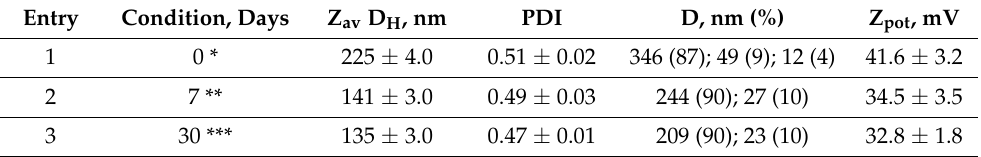
Table 1. Values for the polydispersity indexes (PDI), Z -average (Z av ) diameters, diameters of the populations (D) as percentages (%) and zeta-potentials (Z pot ) of nanoparticles formed by 1,1 (cid:48) -{[3,5-bis((dodecyloxycarbonyl)-4-phenyl-1,4-dihydropyridine-2,6-diyl]bis-(methylene)}bis [4-(anthracen-9-yl)pyridin-1-ium] dibromide ( 4 ) at a concentration of 0.1 mM in an aqueous solution obtained by DLS measurements. The PDI value describes the polydispersity of a sample; the D of a population shows the size of each fraction of nanoparticles (%), the Z av diameter represents the average hydrodynamic diameter of all nanoparticles in the sample and the Z pot value gives information about the surface charge of the nanoparticles. Entry Condition, Days Z av D H , nm PDI D, nm (%) Z pot , mV 1 0 * 225 ±